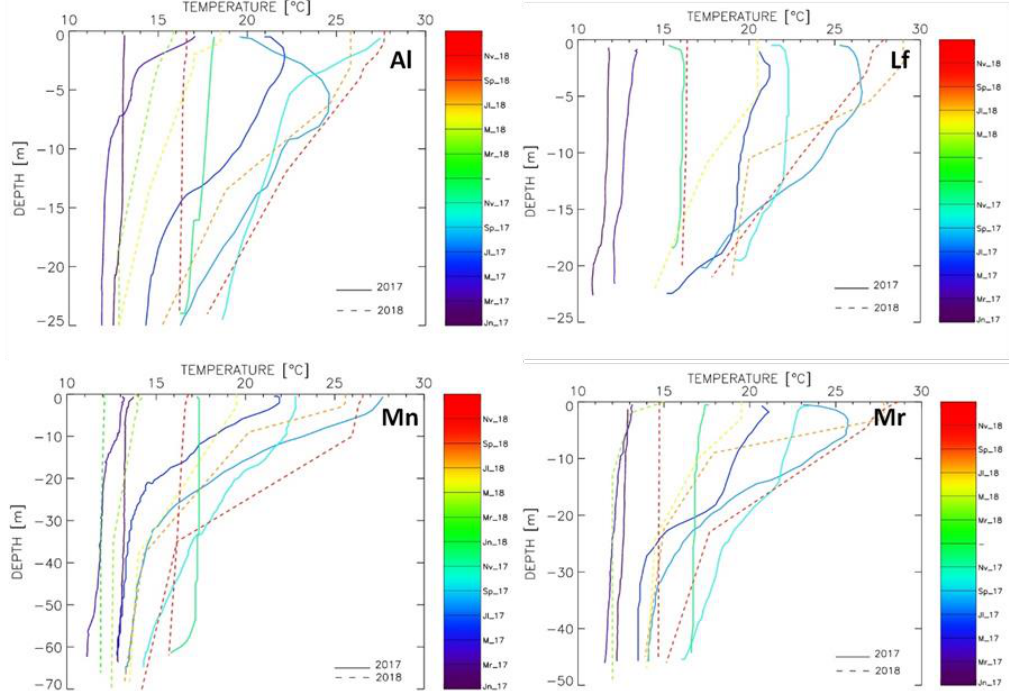
Figure 4. Temperature profiles, at the four sampling locations at Alqueva reservoir, in the months of January (Jn), March (Mr), May (M), July (Jl), September (Sp) and November (Nv), during 2017 (full lines) and 2018 (dashed lines). Al–Á lamos, Lf–Lucefécit, Mn–Montante and Mr–Mourão.